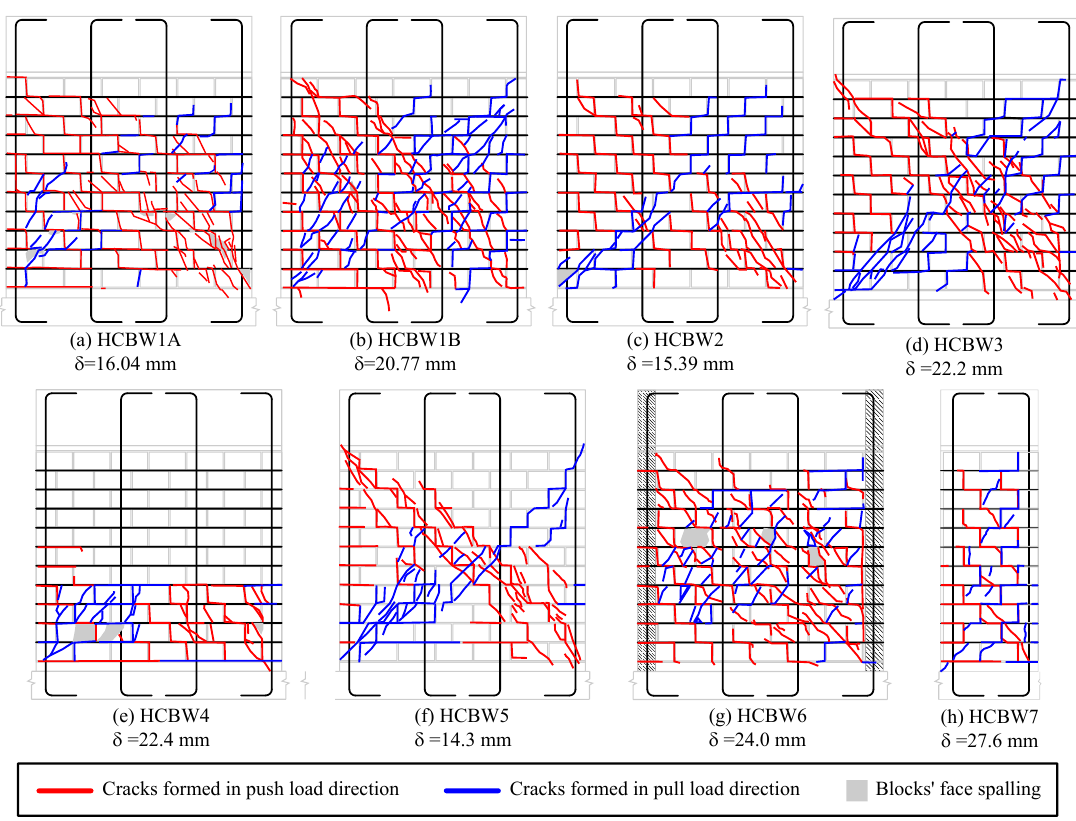
Figure 10. Crack patterns observed at the end of the tests on the walls: ( a ) HCBW1-A, ( b ) HCBW1-B, ( c ) HCBW2, ( d ) HCBW3, ( e ) HCBW4, ( f ) HCBW5, ( g ) HCBW6, and ( h ) HCBW7.